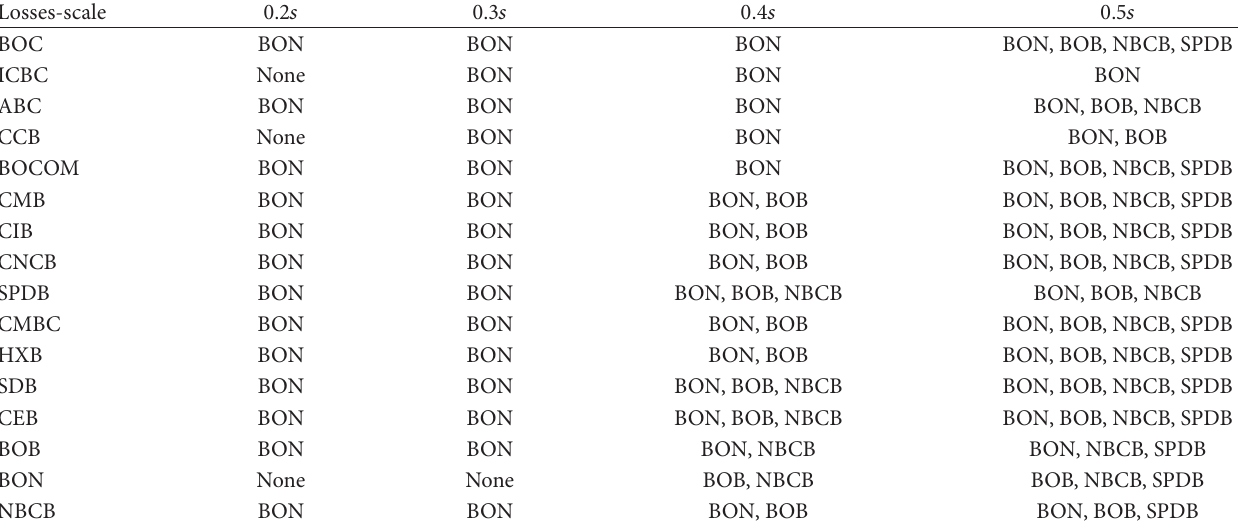
Table 5: The process of banks facing collapse under different